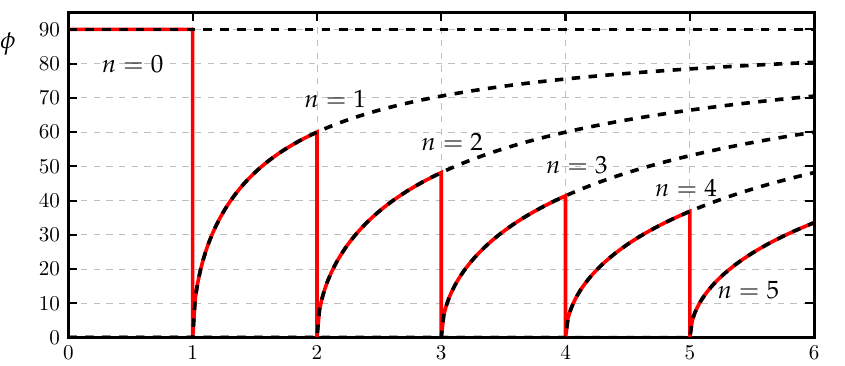
Figure 7. Showing the orientations of the preferred modes (black dotted lines) when the layer is horizontal and for which Ra c = 4 π 2 . The given values of n correspond to the number of cells in the spanwise direction. The red line depicts the preferred mode when | α | (cid:28)